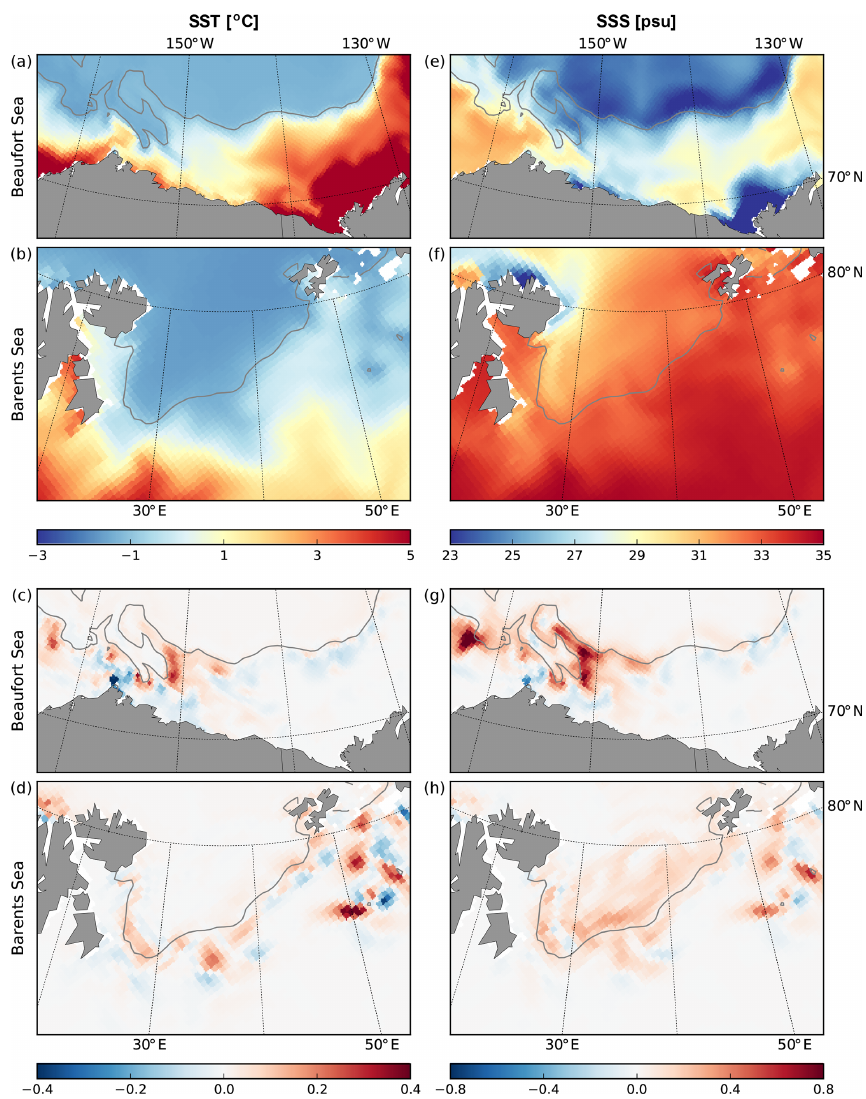
Figure 13. SST (a, b) and SSS (e, f) simulated by the CPL run during the storms that occurred in the Beaufort Sea (a, e) and in the Barents Sea (b, f) on 16–17 August 2010. Panels (c, d, g, h) show the differences for these quantities between the CPL and NOT_CPL simulations. Grey contours indicate the position of the ice edge determined from the averaged sea ice concentration ( c = 0 .